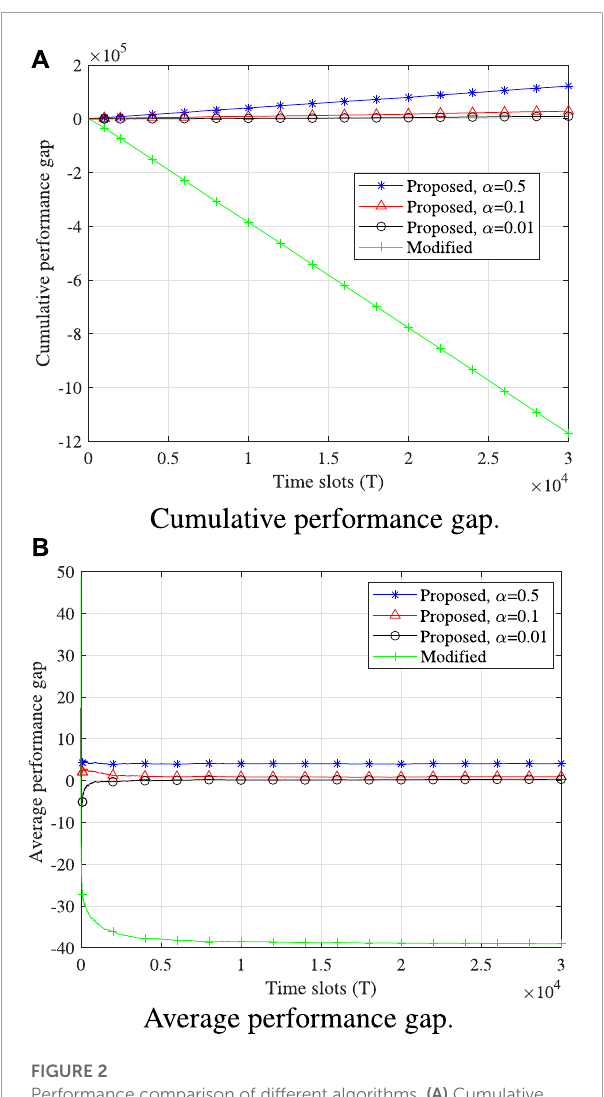
FIGURE 2 Performance comparison of different algorithms. (A) Cumulative performance gap over the time slots. (B) Average performance gap over the time